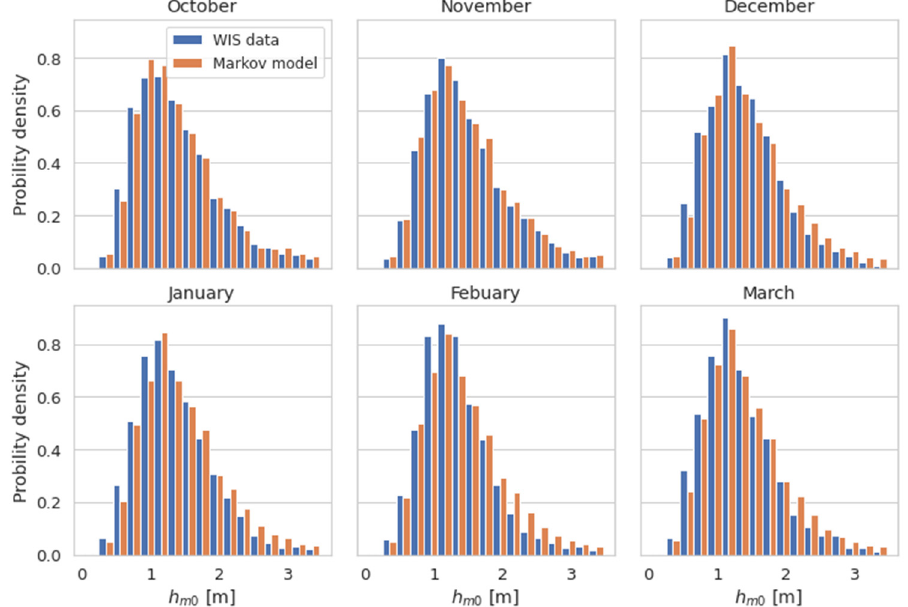
Figure 5. Monthly wave height PDFs of the WIS (blue) and Markov chain model results (orange) used as input to the VB scenario. Starting at the upper left, and from left to right, the panels show PDFs for October through March.